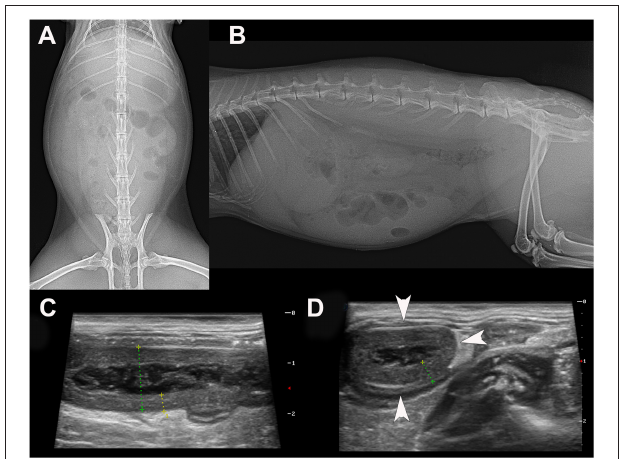
FIGURE 1 | Ventrodorsal (A) and lateral (B) radiograph of the 16-month-old rabbit that was suffering from appendicitis. Note the soft tissue opacity due to chymus in the GI tract because the client had syringe-fed the animal with a recovery diet. A small amount of gas is seen in the caecum. The radiograph is inconclusive for the diagnosis of any GI tract disorder. On abdominal ultrasound, note the tubular organ on longitudinal (C) and transverse section (D) . Both views showed a thickened, hypoechoic wall with a lumen content of heterogeneous echogenicity, which was confirmed by surgery. The inflamed appendix was filled with necrotic material. The size of the whole of the transverse section of the appendix was 12.5mm with a wall thickness of 3.7mm.